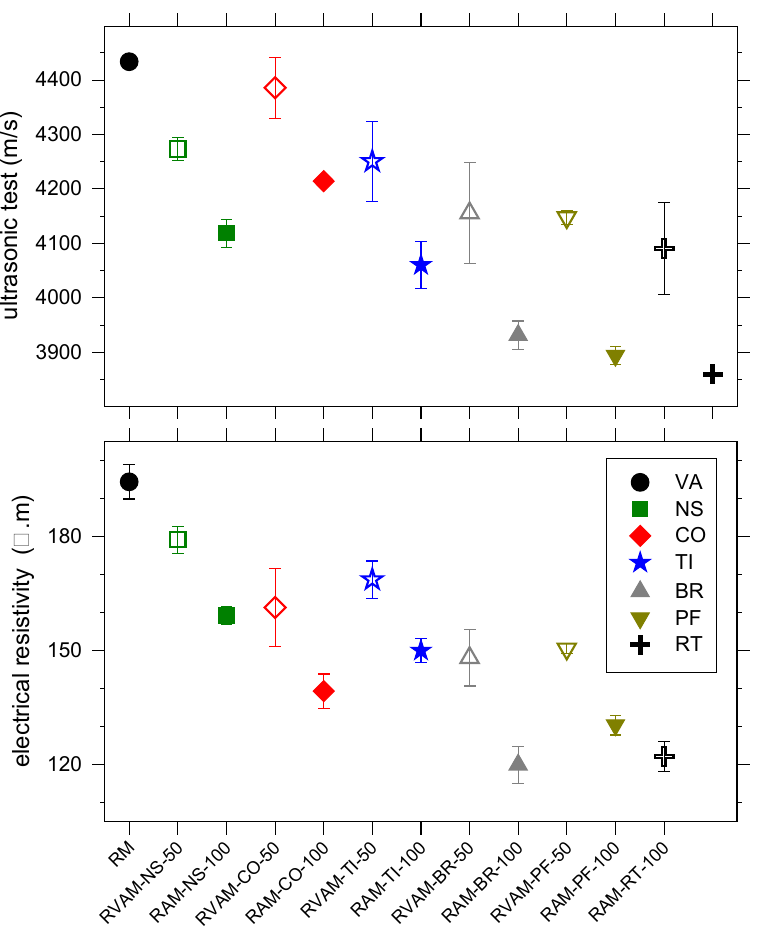
Figure 5. Variation of ultrasonic pulse velocity ( top ) and electrical resistivity ( bottom ) for RM, RVAMs (unfilled symbols) and RAMs (filled symbols).